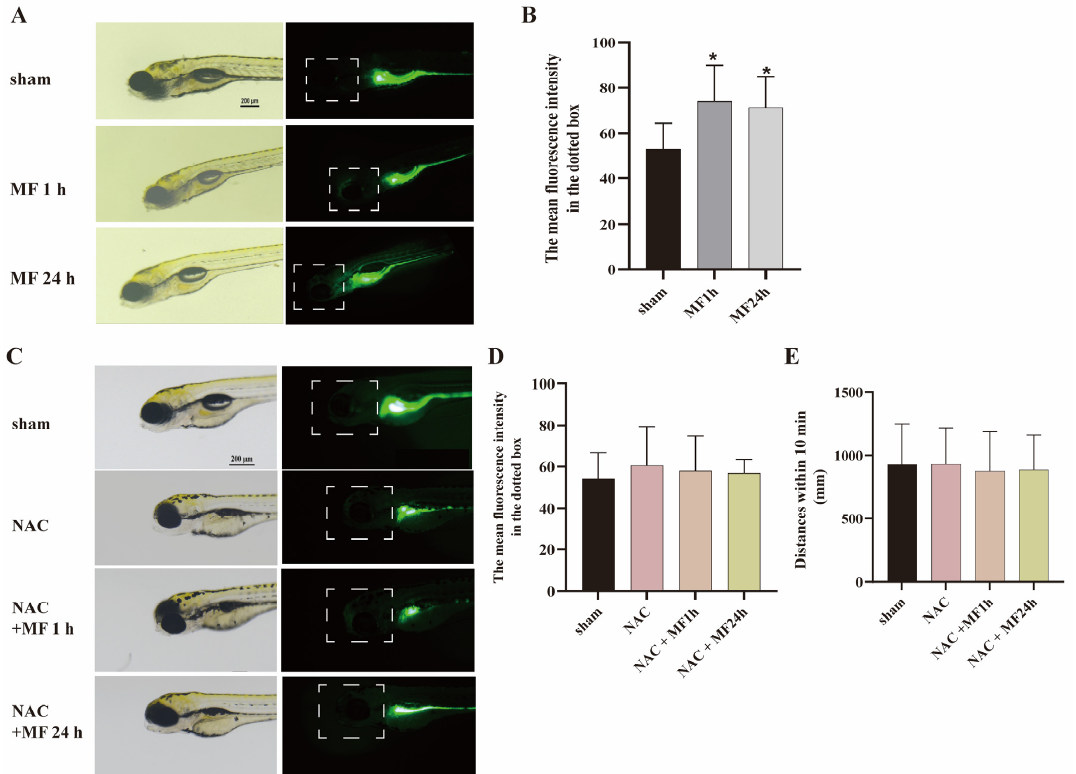
Figure 4. 50-Hz MF exposure-induced SM hypoactivity depended on ROS. ( A ) MF exposure increased ROS level in the brain in zebrafish larvae. The left were photos in bright field light and the right were photos in blue excitation light under a fluorescence microscope. The dotted box was the location of the brain. Scale bar represents 200 µ m; ( B ) The fluorescence intensity of ROS in the brain (dotted box) was increased after exposure to MF 1 h and 24 h every day for 5 days; ( C ) NAC pretreatment could inhibit MF-induced ROS in zebrafish larvae. The left were photos in bright field light and the right were photos in blue excitation light under a fluorescence microscope. The dotted box was the location of the brain. Scale bar represents 200 µ m; ( D ) Pretreatment with NAC inhibited MF-increased ROS in the brain (dotted box) of zebrafish; ( E ) Pretreatment with NAC restored MF-inhibited SM distance of zebrafish at 120 hpf. * p < 0.05, compared with